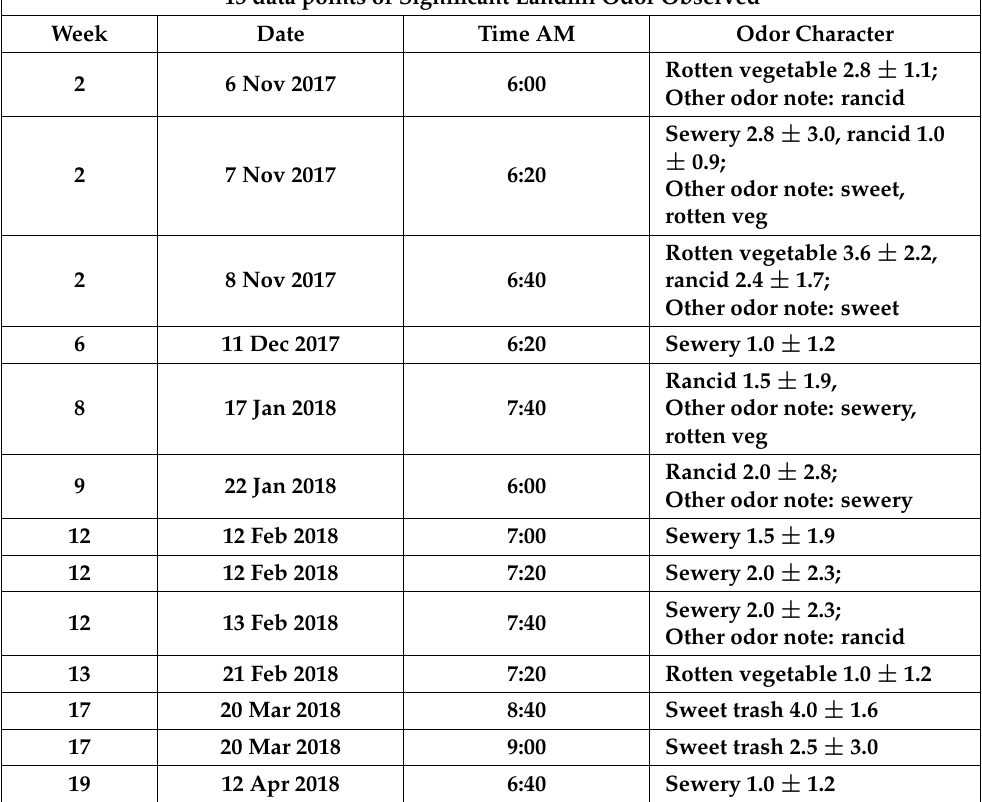
Table 3. The 13 Odor Panel Sample Data When Landfill Odors Were Observed during the “Odor Patrol Study “of 100 midweek days. Note: environmental background odors were not included in this data